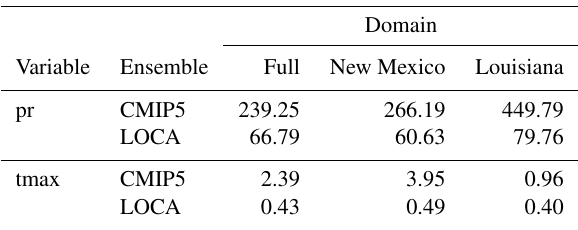
Table 4. RMSE of precipitation (mm) and high temperature ( ◦ C) for unweighted